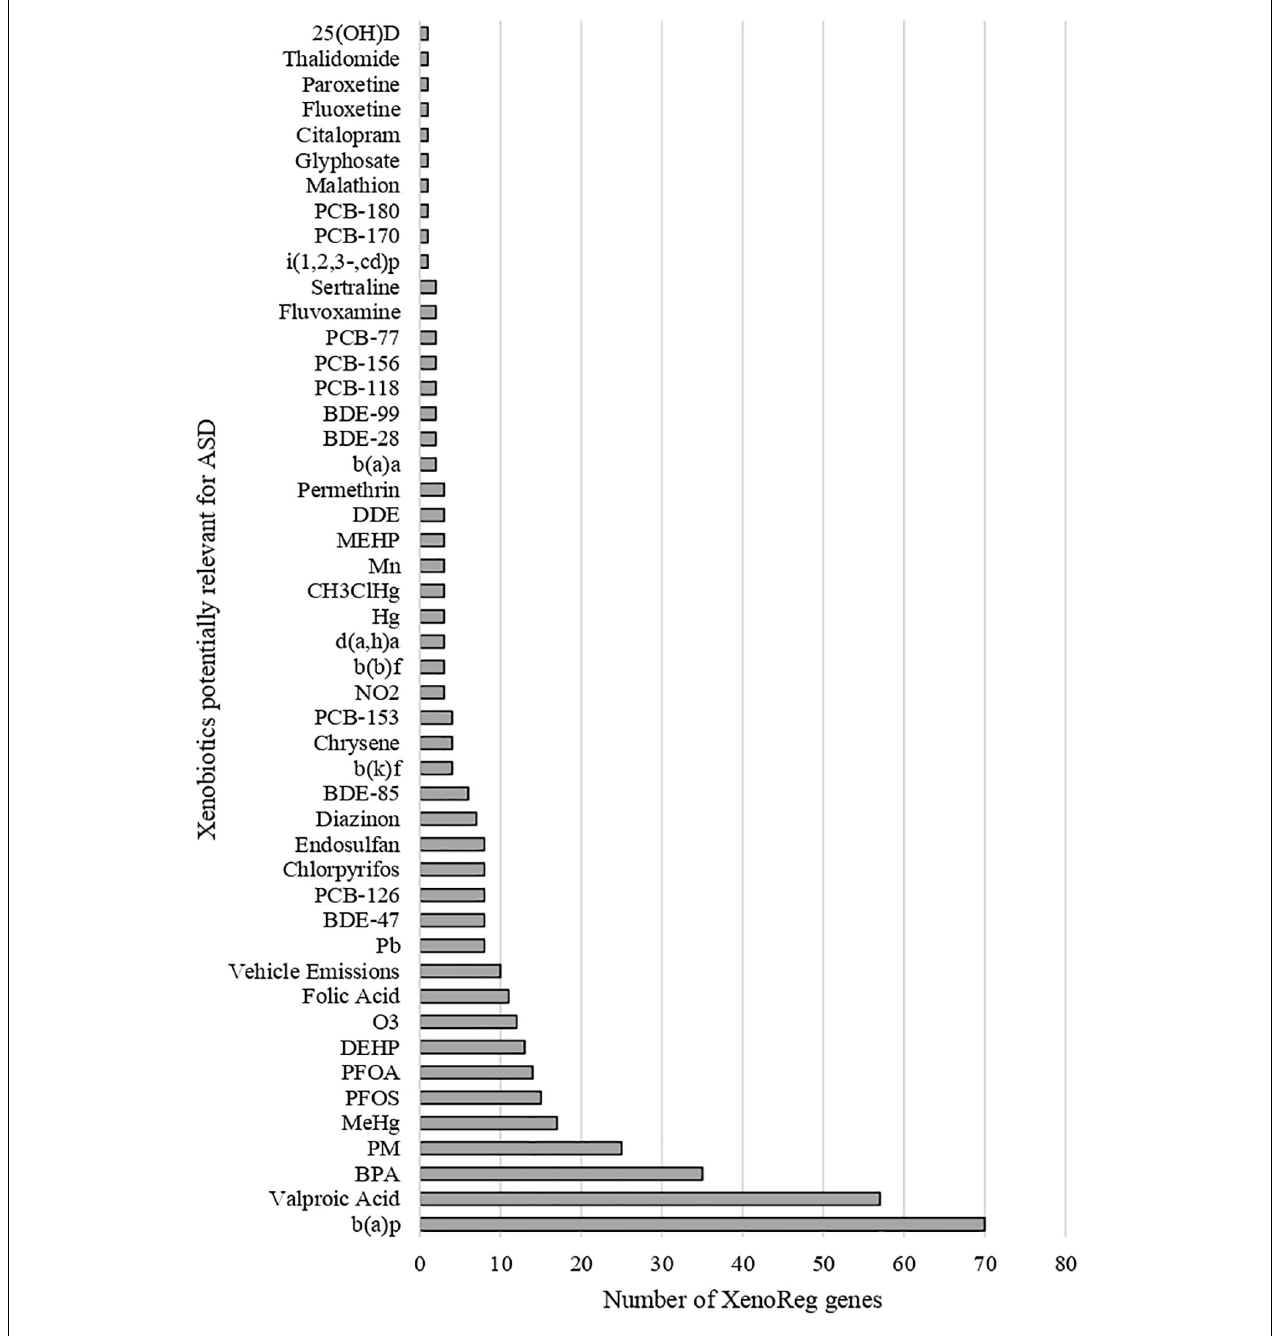
FIGURE 5 | Gene interactions per xenobiotic. Number of high evidence XenoReg genes with predicted damaging variants that interact with any of the xenobiotics previously linked with ASD, according to The Comparative Toxicogenomics